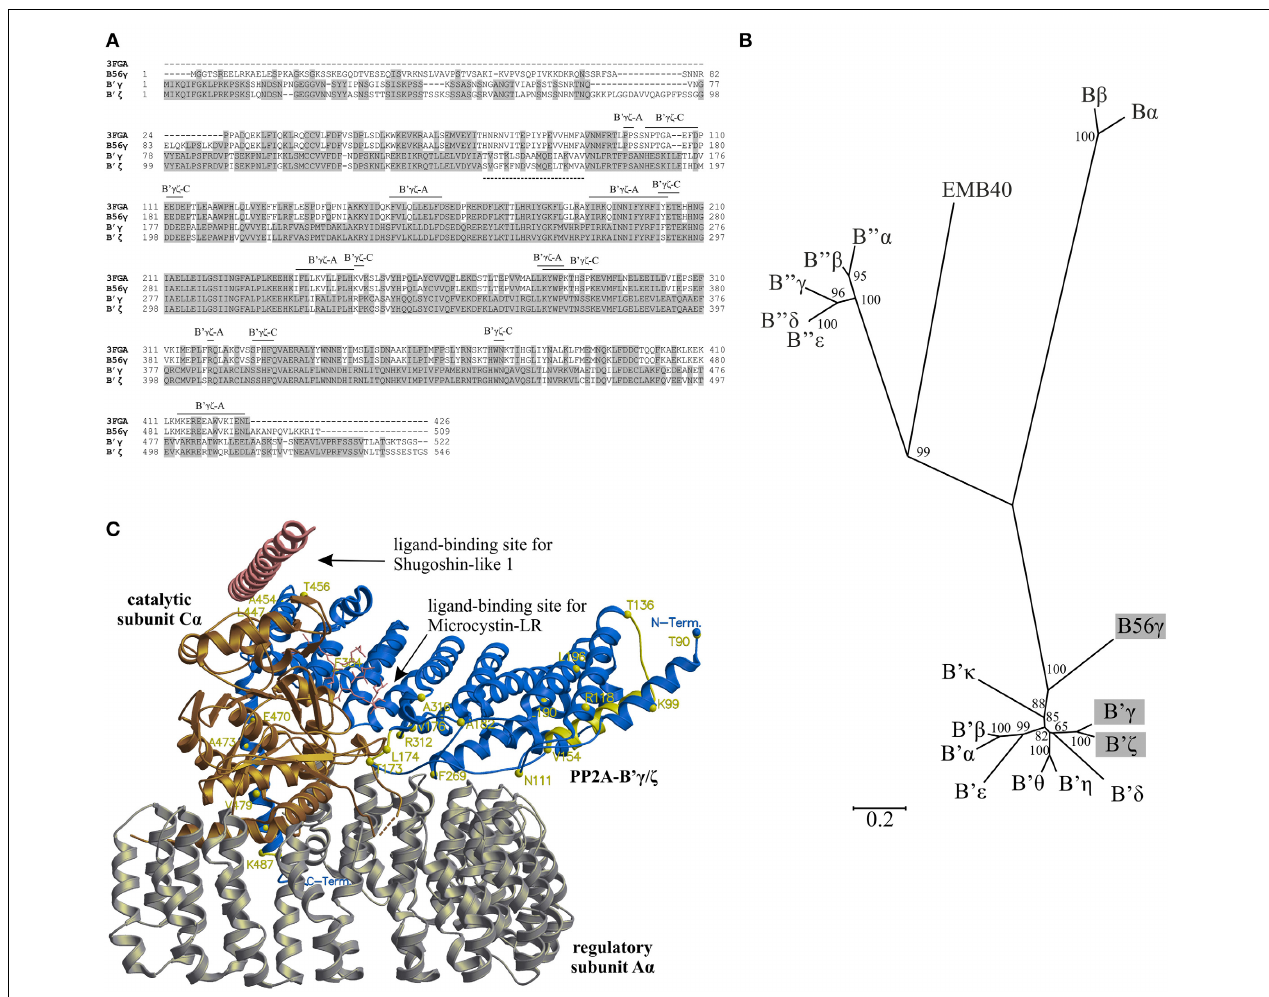
FIGURE 1 | Structural properties of PP2A-B’ γ and PP2A-B’ ζ . (A) Amino acid sequence alignment between A. thaliana PP2A-B’ γ (B’ γ ) and PP2A-B’ ζ (B’ ζ ), human PP2A-B56 γ , and the sequence of PP2A-B56 γ from the X-Ray structure (PDB Code: 3FGA). Gray areas indicate sequence identity and the lines indicate areas of interactions between PP2A-B’ γ or PP2A-B’ ζ and the PP2A-A and PP2A-C subunits, based on the structure of 3FGA. The dashed line indicates a variable segment between PP2A-B’ γ and PP2A-B’ ζ . B α , AT1G51690; B β ,AT1G17720; B’ α , AT5G03470; B’ β , AT3G09880; B’ γ , AT4G15415; B’ δ , AT3G26030; B’ ε , AT3G54930; B’ ζ , AT3G21650; B’ η , AT3G26020; B’ θ , AT1G13460; B’ κ , AT5G25510; B” α , AT5G44090; B” β , AT1G03960; B” γ ,AT1G54450; B” δ , AT5G28900; B” ε , AT5G28850; EMB40, AT5G18580; B56 γ , Q13362. (B) Unrooted phylogeny tree showing